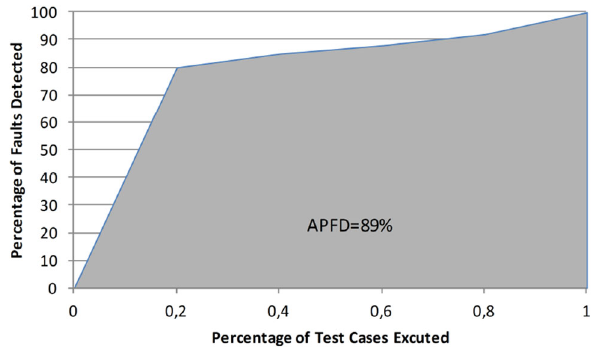
Fig. 7 APFD of BITCP algorithm for an arbitrary test suite region of the curve. Circles denote the general dis-